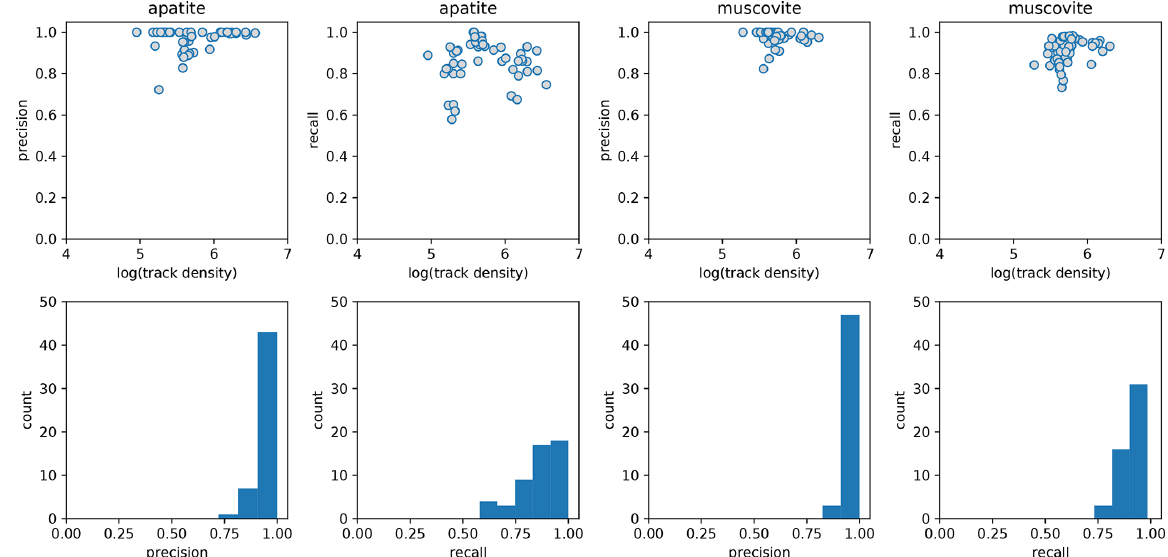
Figure 4. Performance metrics of the deep neural networks obtained on a dataset containing 50 “test images”. The precision (true posi- tives / (true positives + false positives)) and recall (true positives / (true positives + false negatives)) of the automatic fission track recognition deep neural network are shown for apatite and muscovite mica (external detector). The 10-based log of areal track density (trackscm − 2 ) is shown on the horizontal axis of the upper scatter plots. The frequency histograms below show the distribution of the performance metrics.